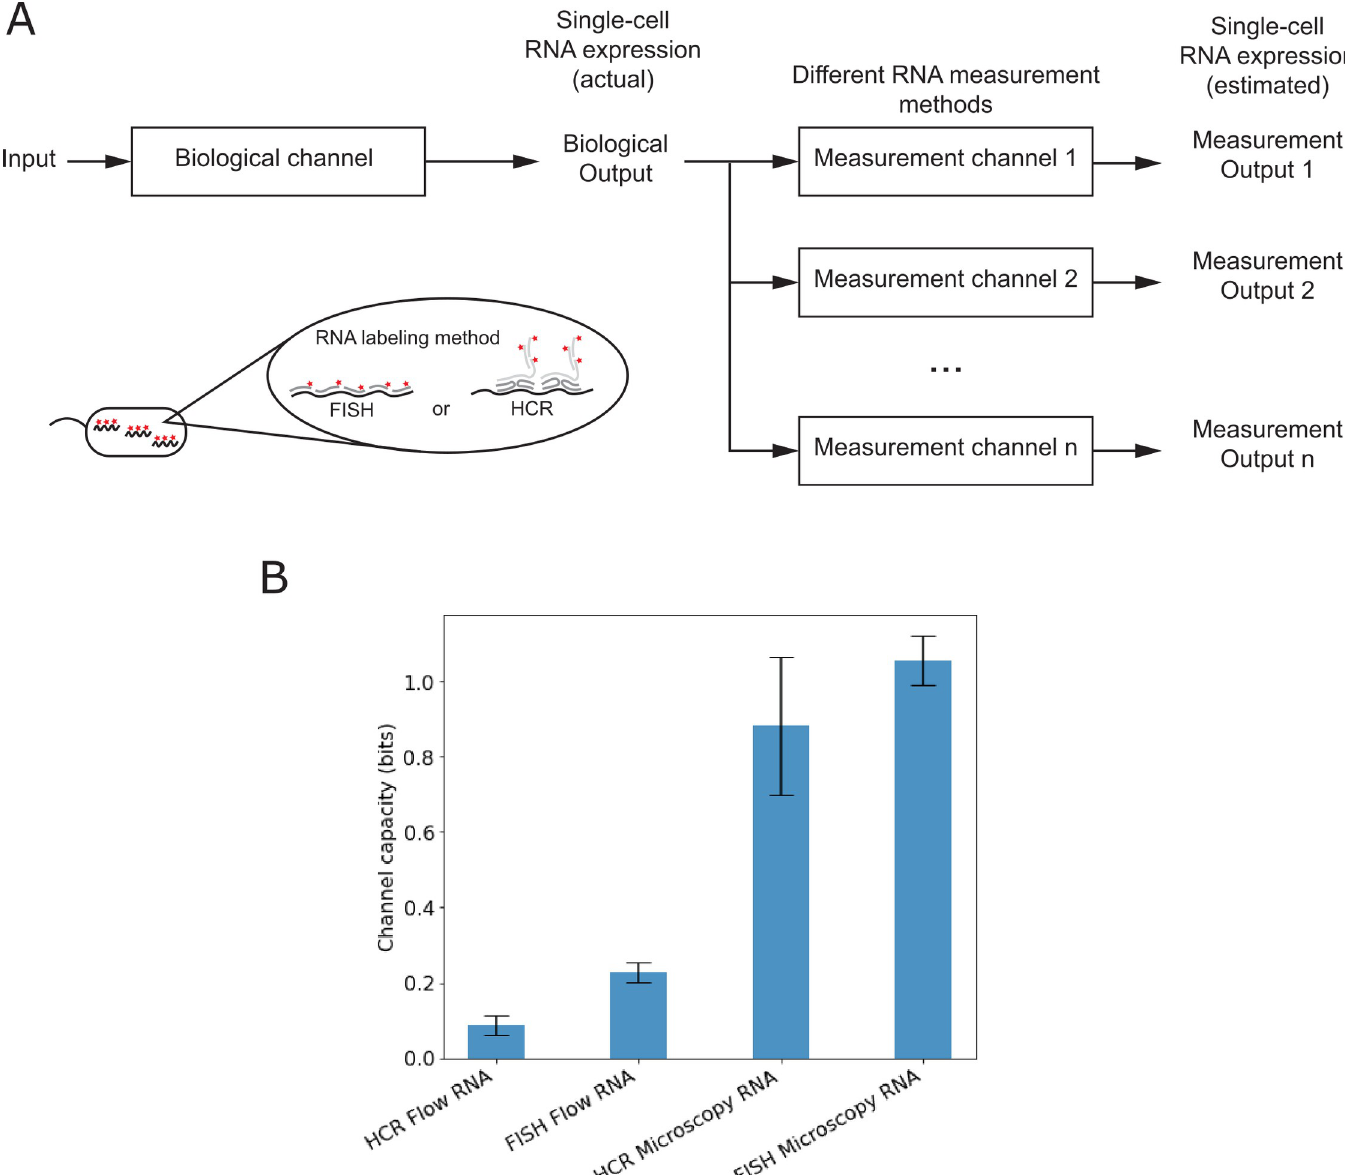
Fig 2. Single-cell measurement quality of RNA expression, in bits. (A) Different single-cell methods of measuring RNA use different steps for sample preparation and signal detection. Examples of sample preparation include RNA-labeling methods such as fluorescence in situ hybridization (FISH) or hybridization chain reaction (HCR) (inset). Examples of signal detection include microscopy and flow cytometry. When different single-cell methods are used to analyze the same biological output, the channel capacity between input and different measurement outputs can be used to compare single-cell measurement quality of RNA, in bits. (B) Channel capacities of different single-cell methods of estimating RNA from the same biological channel (mean +/- standard deviation of three biological replicates). https://doi.org/10.1371/journal.pone.0269272.g002 for RNA detection using FISH or HCR. For different fluorescent protein measurement meth- ods, we observed a wide range of channel capacities (Fig 3, Tables 2 and 3). Flow cytometry detection of fluorescent protein following FISH labeling had the lowest channel capacity ( � 0.19 bits), while flow cytometry detection after antibiotic treatment had the highest channel capacity ( � 1.6 bits).